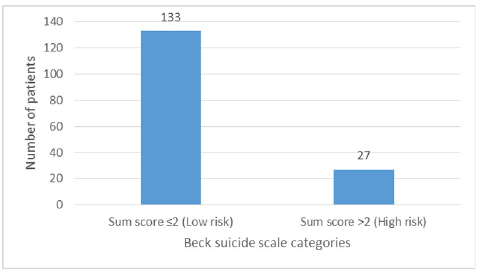
Fig 2. Beck suicidal scale categories for suicide.